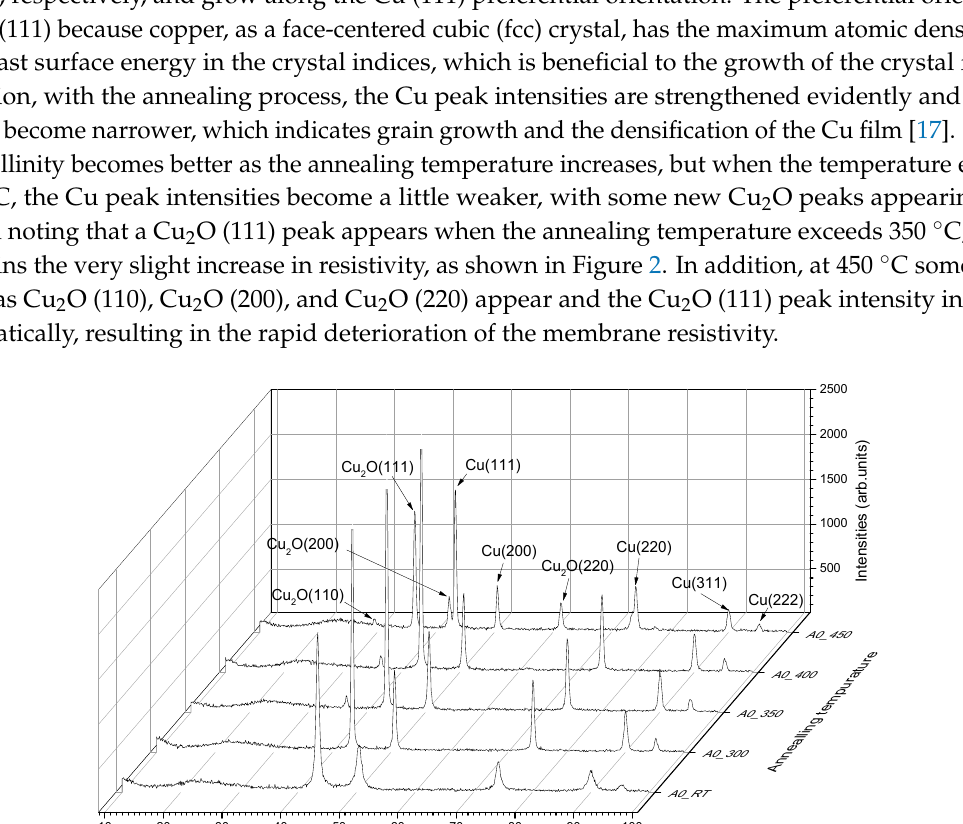
Figure 7. The XRD of Cu-Cr-Zr thin-film samples ( a ) at room temperature (RT), and after annealing at ( b ) 300 °C; ( c ) 350 °C; ( d ) 400 °C; and ( e ) 450 °C.